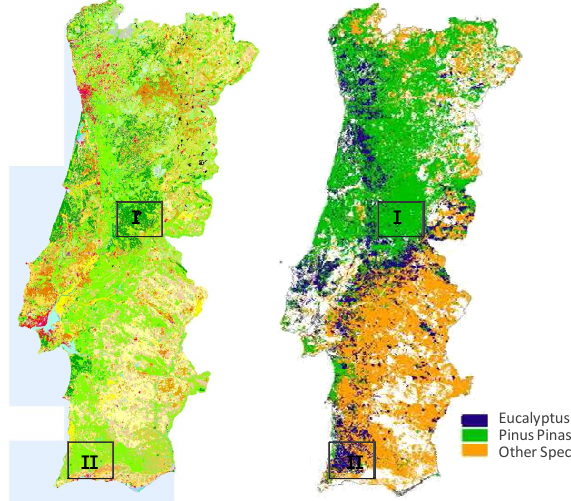
Fig. 1. Map of vegetation types over Portugal (left panel) accord- ing to the Corine Land Cover 2000 (CLC2000) classification and map of distribution of Eucalyptus and Pinus Pinaster over Portugal (right panel) provided by the Portuguese National Forest Authority (ANF). Rectangular frames in both panels indicate the geographi- cal location of the two selected Regions, I and II, respectively in Central and in Southwestern